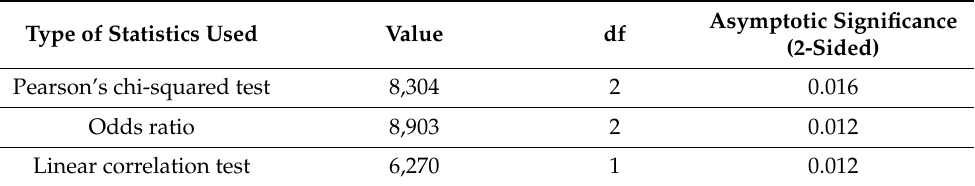
Table 9. The type of company and assignment of a buddy (Pearson’s chi-squared test). Type of Statistics Used Pearson’s chi-squared test Linear correlation